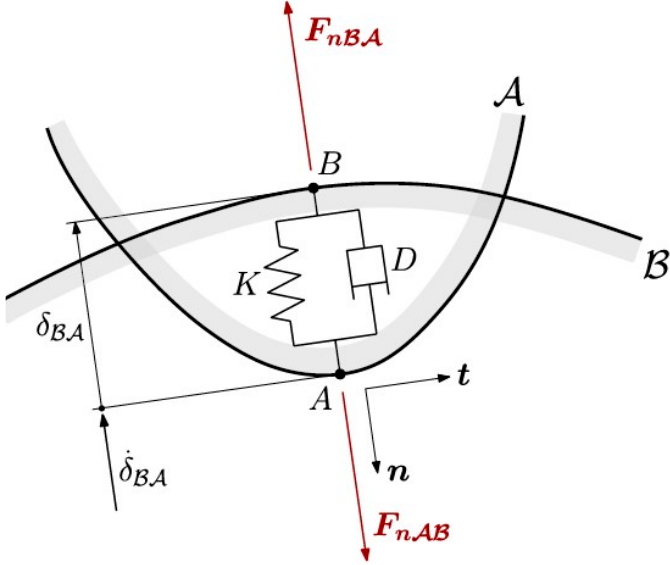
Figure 12. Linear spring–damper for frictionless contact modeling.